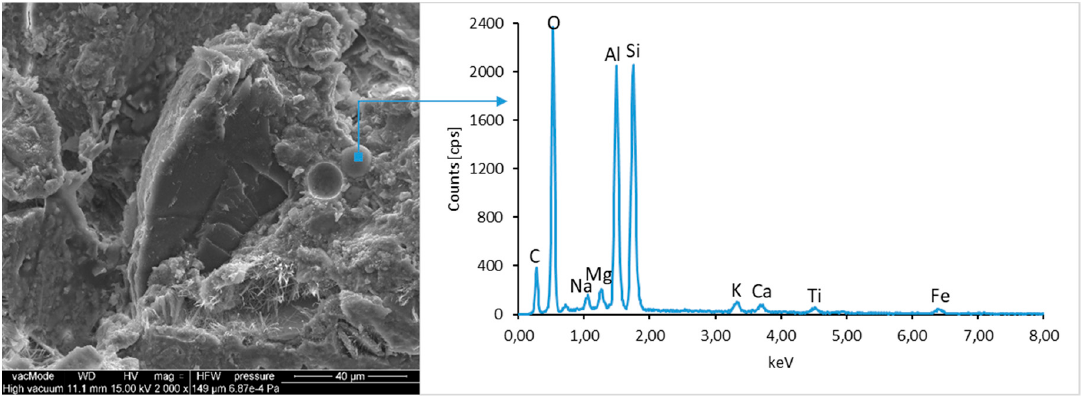
Figure 14. SEM micro-structure of CII.1 concrete and results of elemental analysis in EDS micro-area for spherical forms of fly ash, angular LCD forms and needle-like forms of C–S–H phase are visible. Materials 2019 , 11 , x FOR PEER REVIEW 16 of 22